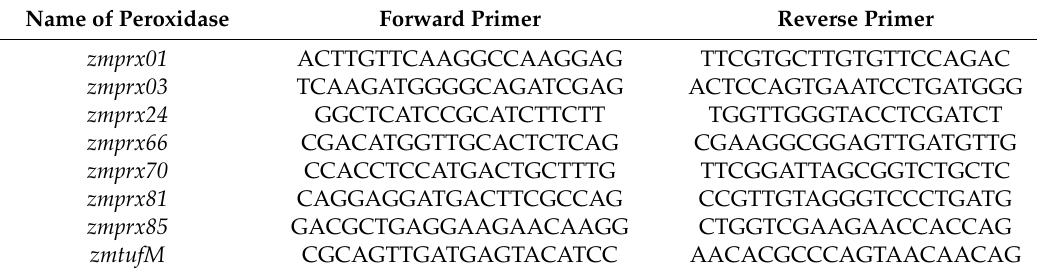
Table 1. Primer sequences in 5 (cid:48) -3 (cid:48) -orientation for RT-qPCR. Name of